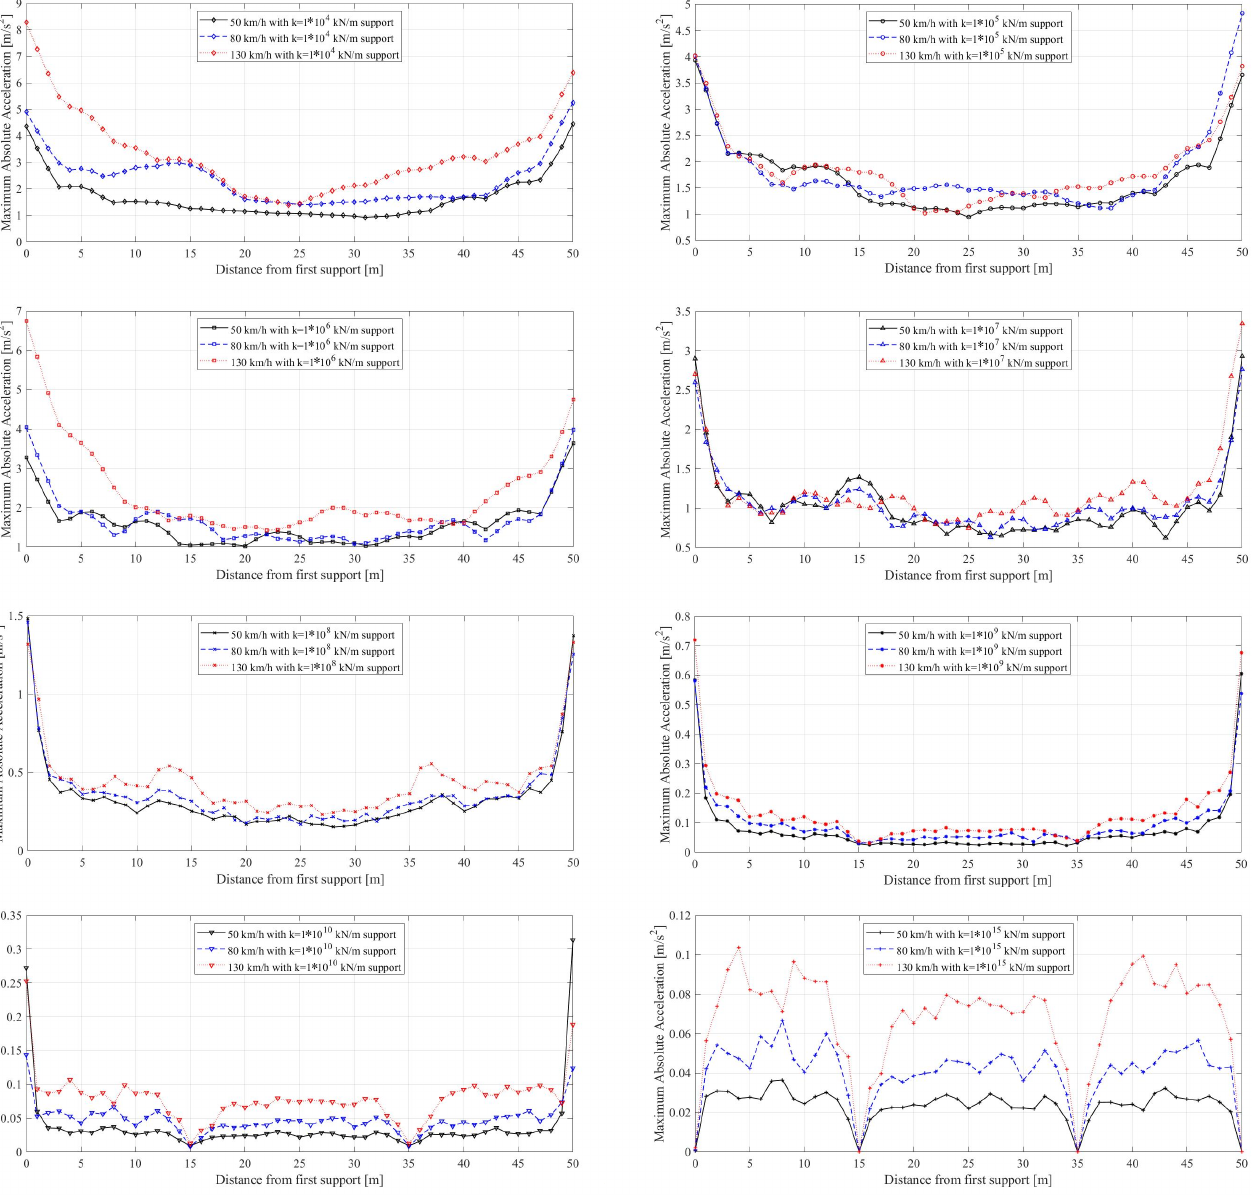
Figure 15. Absolute Maximum Accelerations along the bridge length for different bearing stiffness and train speeds for the three span